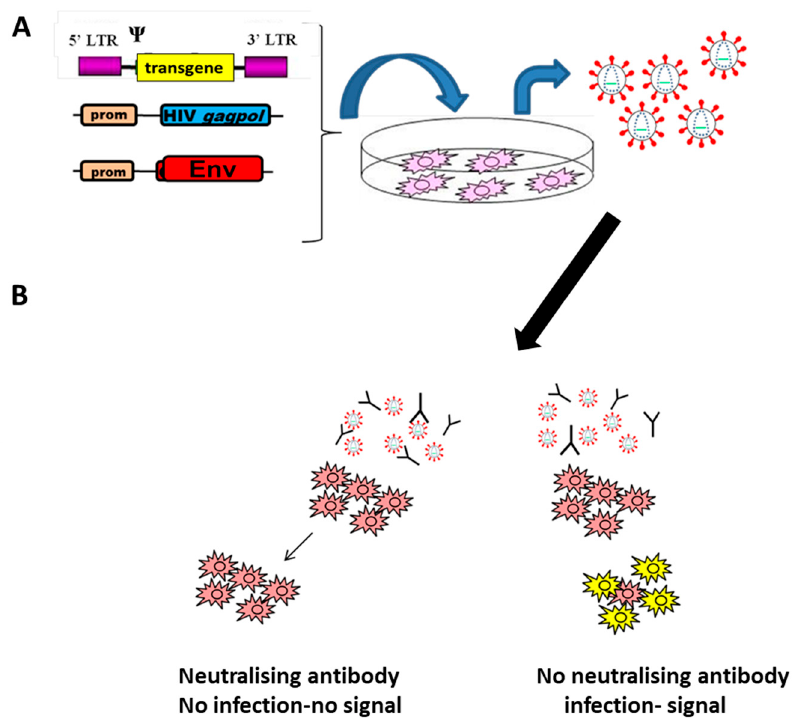
Figure 1. Application of pseudotyped lentiviral vectors (LVs) to neutralisation assays. Pseudotyped lentiviral particles are generated by transfection of a permissive cell line (e.g., HEK293T) with a mix of plasmids coding for HIV-1 structural and enzymatic proteins (HIV gagpol), the lentiviral vector with a transgene of interest, e.g., luciferase, GFP, contained within the HIV long terminal repeats (LTR) and an expression plasmid coding the Env of the virus of interest. Particles are collected in the supernatant of the transfected cells usually 48–72 h post-transfection ( A ). In a neutralisation assay, the pseudotyped LV particles are incubated with the serological sample to test before adding to the target cells. If no neutralising antibody is present, the pseudotyped LV will enter the target cells, and the transgene will be expressed, and infection can be monitored by the signal produced. Neutralising antibody in the sample will inhibit LV entry and no signal will be visible ( B